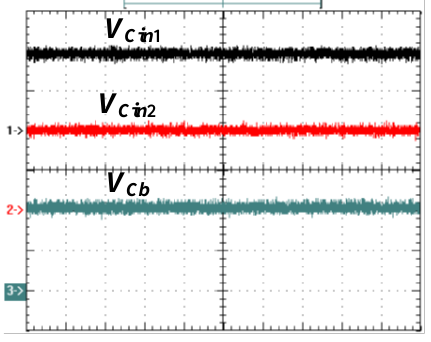
Figure 9. Measured waveforms of split voltages V Cin1 and V Cin2 and balance capacitor voltage V Cb at 800 V input and full load (V Cin1 , V Cin2 , V Cb : 200 V / div; time: 4 µ s /div).